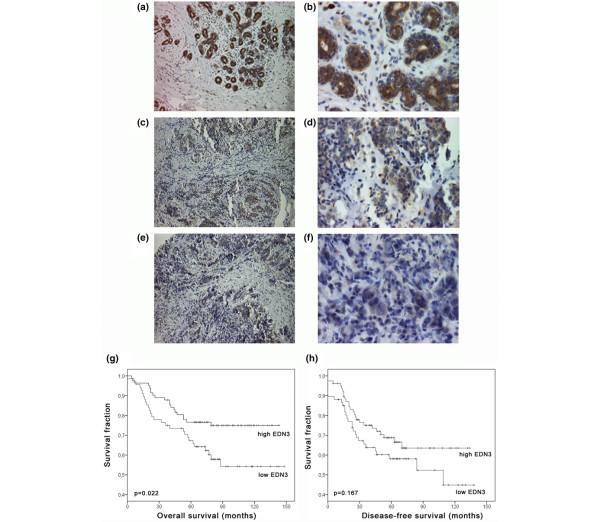
Differential EDN3 protein expression in human breast cancer and its clinical relevance. (a) Abundant EDN3 protein expression in normal breast epithelium. (b) Magnification of specimen shown in (a). (c) Representative invasive-ductal carcinoma showing moderate EDN3 protein expression. (d) Magnification of specimen shown in (c). (e) Representative invasive-ductal carcinoma with substantial loss of EDN3 protein expression. (f) Magnification of specimen shown in (e). Kaplan-Meier curves indicating that retaining high EDN3 protein expression (immunoreactivity score of at least 8) in the tumour is significantly associated with more favourable (g) breast cancer-specific survival (P = 0.022, log-rank test) but not (h) disease-free survival. Magnifications: ×100 (a, c, e), ×200 (b, d, f). EDN3, endothelin-3.